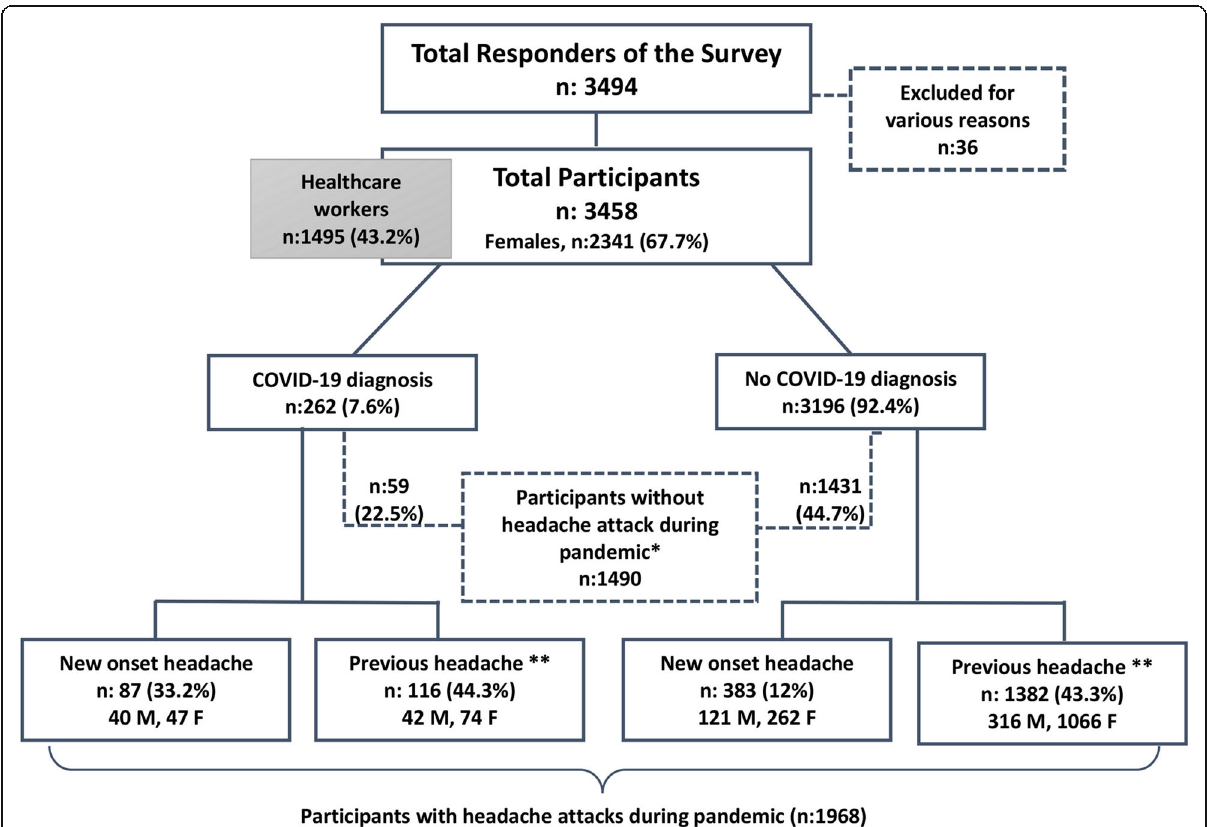
Fig. 1 Flowchart of the study. *Please note that some participants with previous headaches did not experience headache attacks during the pandemic (March – April 2020). **Only those participants with headache attacks during the pandemic could be included in the analyses, done in terms of before-after pandemic comparisons. M; male, F;